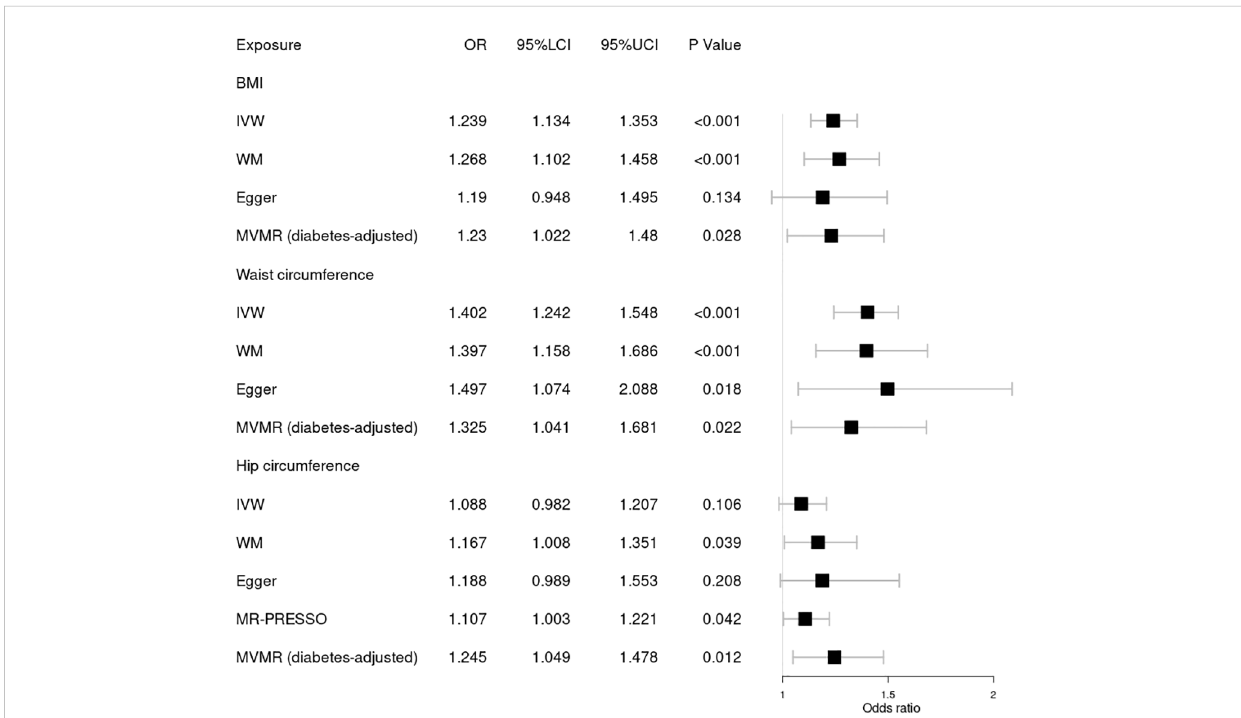
FIGURE 2 Forest plot of Mendelian randomization results of obesity effect on DR. BMI, body mass index; IVW, inverse variance weighted; Egger, MR – Egger; WM, weighted-median; MR-PRESSO, the outlier-corrected MR pleiotropy residual sum and outlier results (one signi fi cant outlier; SNV:rs7903146); MVMR, multivariable Mendelian randomization; 95% LCI, lower limit of 95% CI; 95% UCI, upper limit of 95%